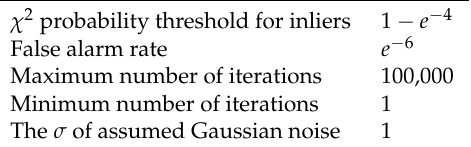
Algorithm 1 on the first image versus the second image in the Lueven sequence at settings of R : 0, 0.01, 0.02, 0.05 and 0.1,